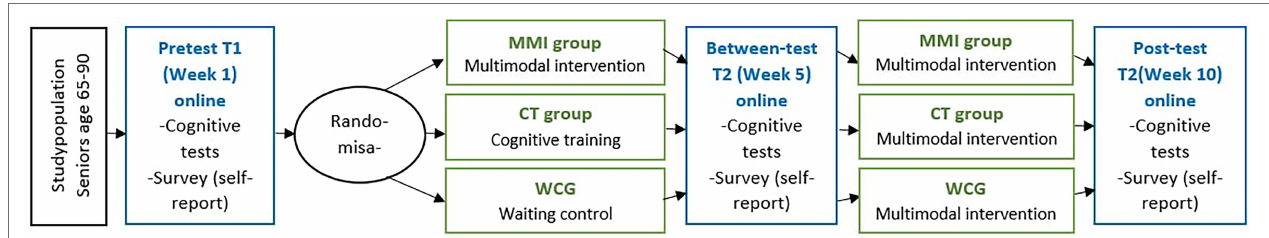
FIGURE 1 | Visualization of the study design. All participants completed repetitive surveys and cognitive tests three times (Pre-test, Between-test, and Post-test). After randomization, they were assigned to three groups, the multimodal intervention (MMI) group, the cognitive training (CT) group, and the waiting control group (WCG). After 5 weeks, they all received the MMI for five more